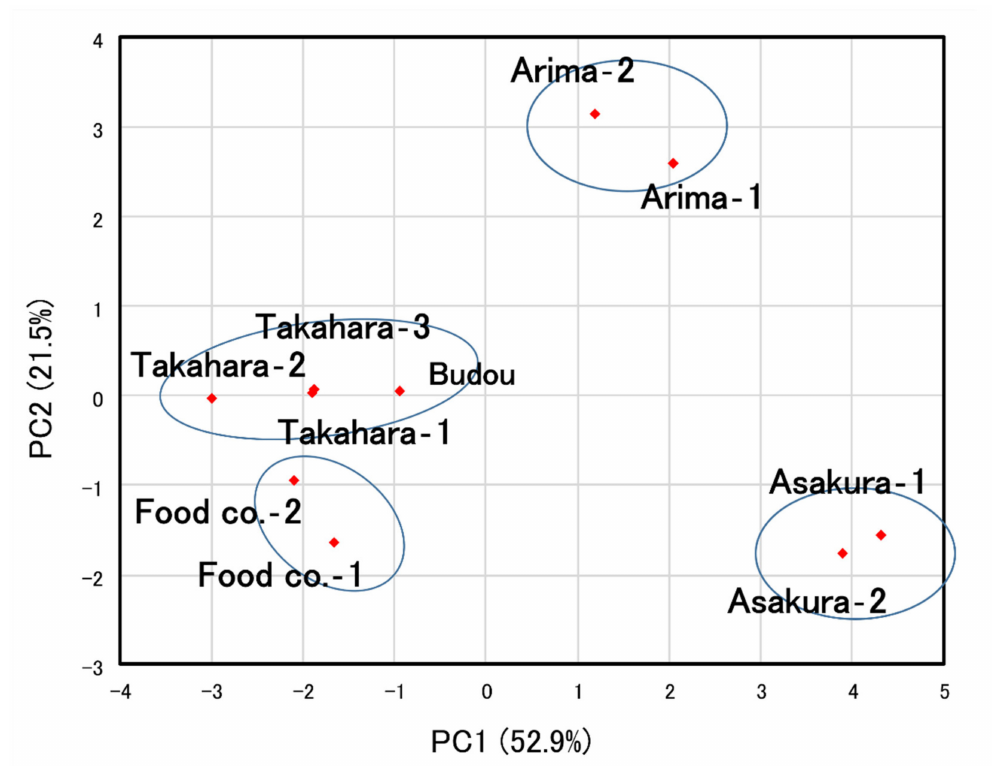
Figure 4. Classification of Japanese pepper based on sensory evaluation. The contribution rate of each principal component is shown in parentheses.